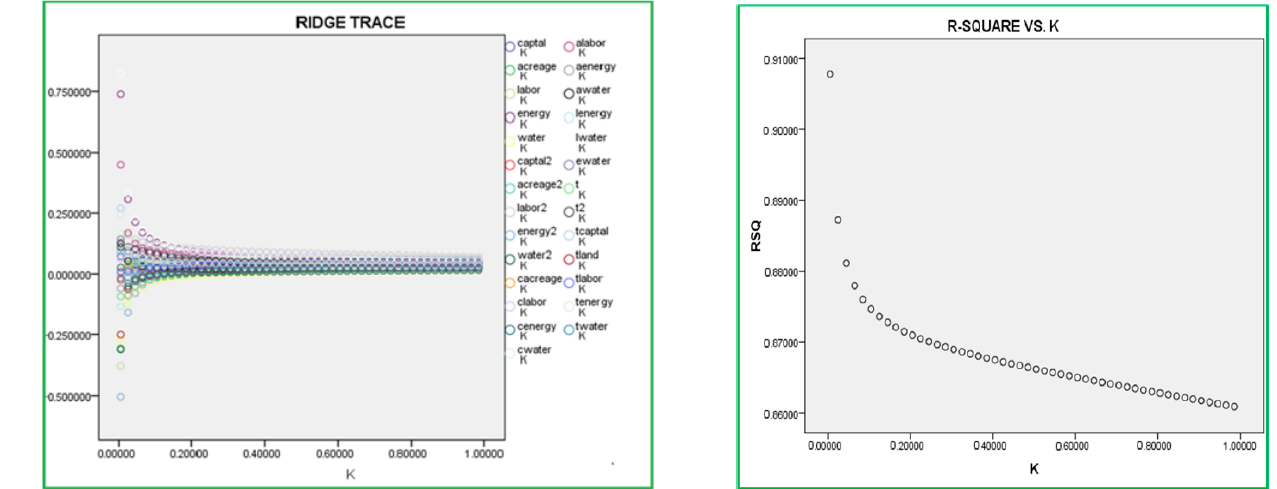
Figure 3. Maps of ridge trace.